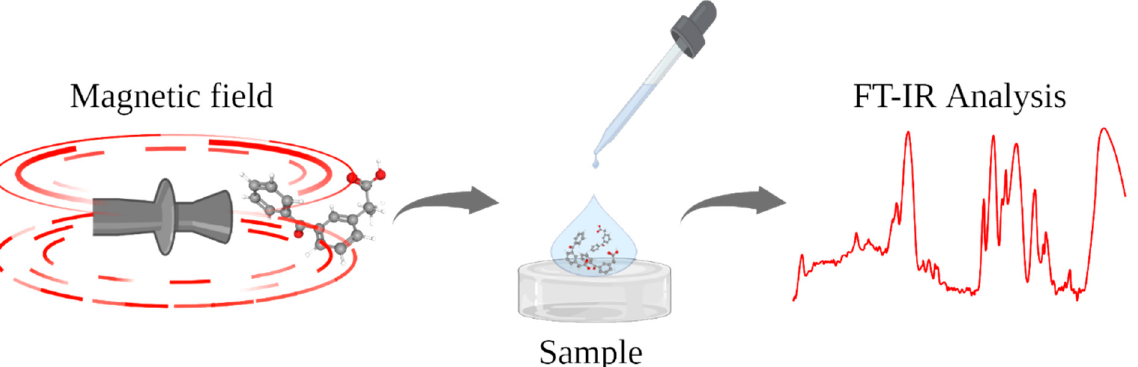
Figure 2. Schematization of the proposed analysis of molecules (i.e., ketoprofen and KiOil) through a diamagnetic pump equipment to generate a controllable MF, and a spectroscopic analysis to investigate its effect.